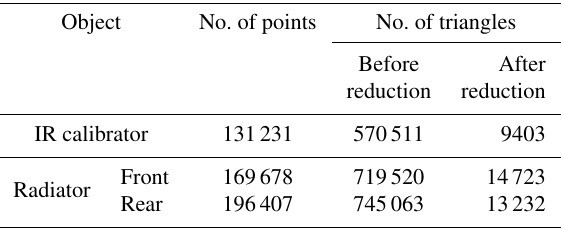
Table 2. Number of points and triangle surface elements of the 3D thermograms after the performed experiments and processing steps. Object